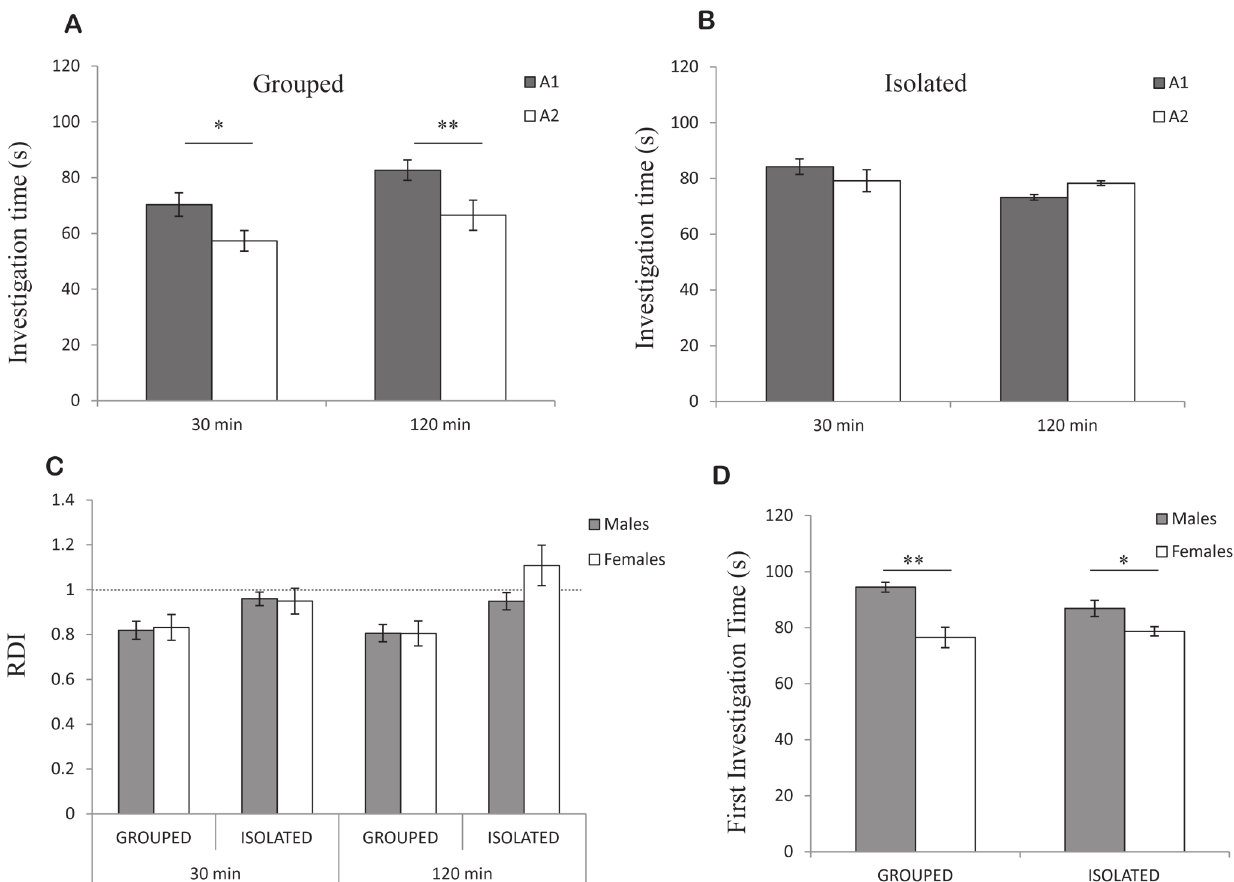
Figure 6. Housing conditions affected acquisition of SRM in female rats (mean ± SEM): A) Females from group housing displayed a significant decrease in the SIT during the second 2 min encounter (A2, empty bars) compared to the first (A1, gray bars) when encounters were separated by 30 or 120 min. Paired t-test: * p , 0.05, ** p , 0.01, n=10 per group. B) Socially isolated females displayed no significant decrease in SIT during the second 2 min encounter. Paired t-test: p . 0.05, n=10 per group. C) RDI values of males vs. females in different housing conditions and different intervals between encounters. No significant difference was found (t-test) between males and females SRM. n=10 per group. D) First investigation time of grouped and isolated males vs. females. In both housing conditions females investigated the social stimuli at the first encounter for significantly less time than males. t-test: * p , 0.05, ** p , 0.01, n=10 per group.